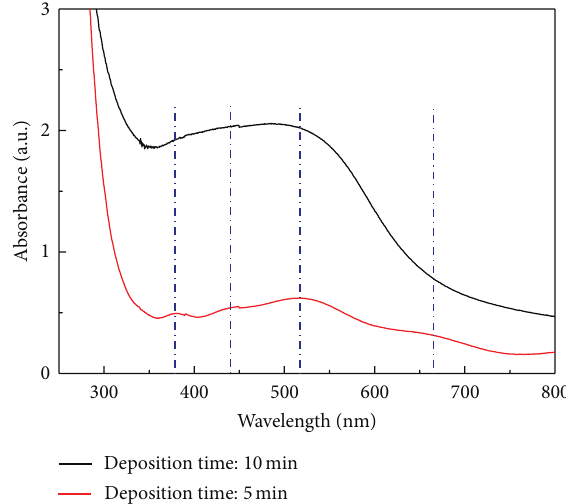
Figure 4: Absorption spectra of Ag:TiO 2 nanocomposite thin film prepared by deposition time 5min and